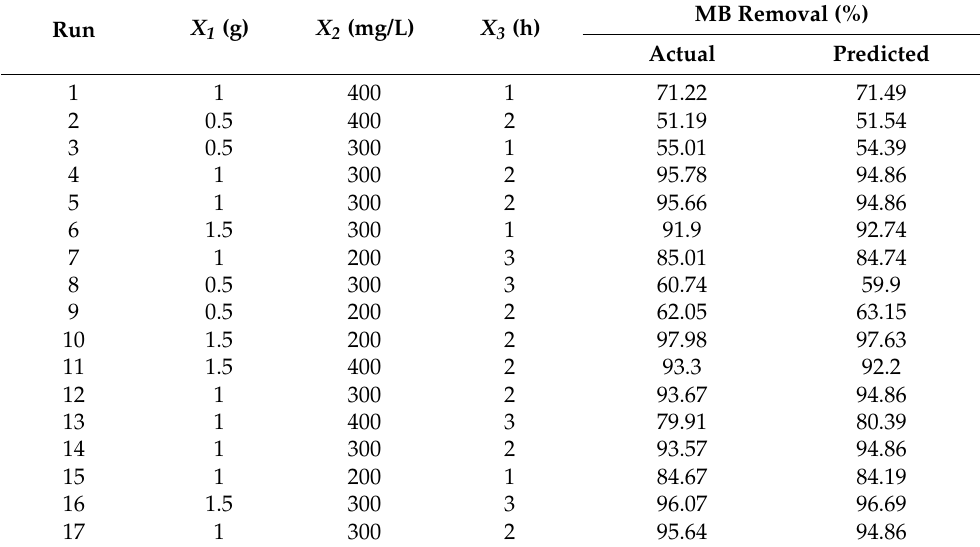
Table 1. Experimental and predicted results for MB removal.